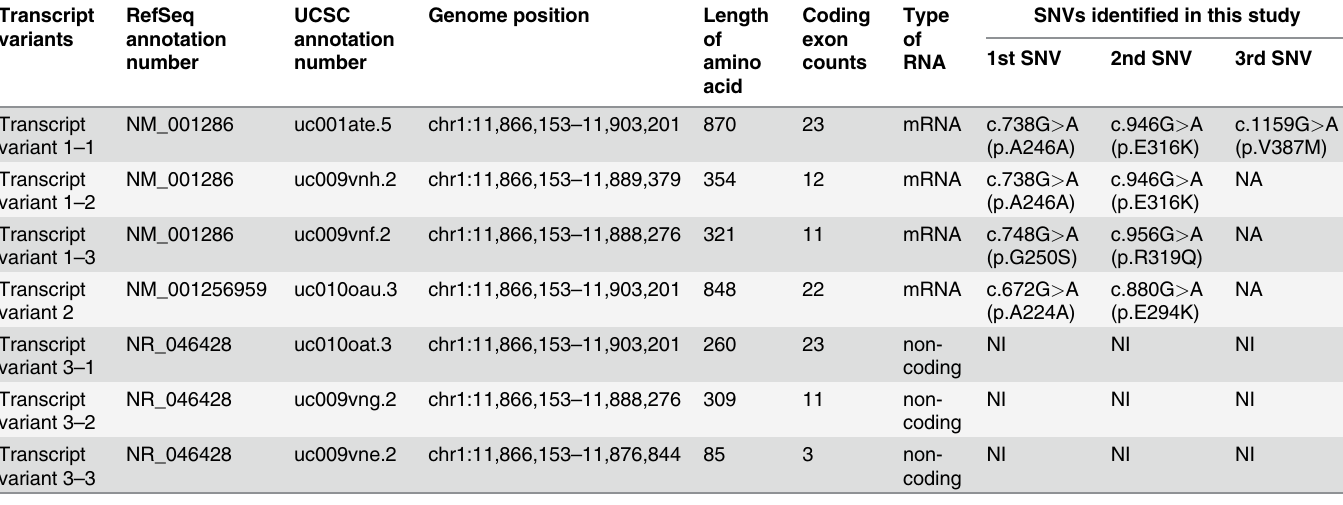
Table 2. CLCN6 transcript variants and identi fi ed variants in this study.